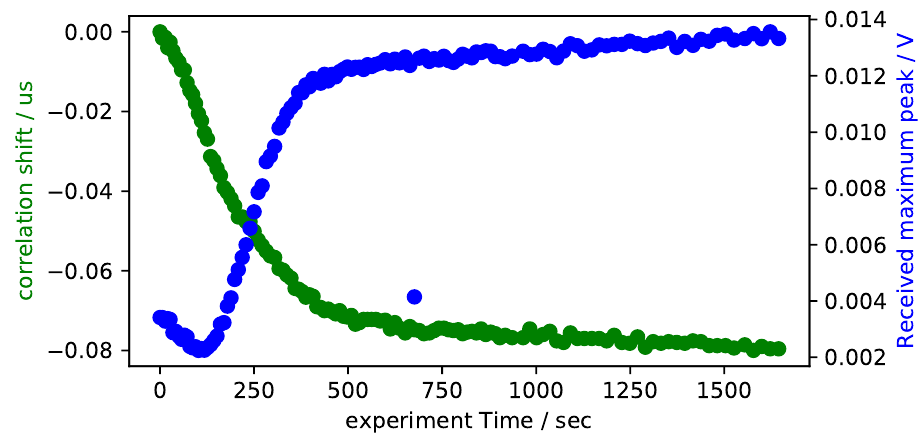
Figure 7. Signal attenuation and cross correlation shift of the experimental data with 5-min epoxy in a steel pultrusion tool.